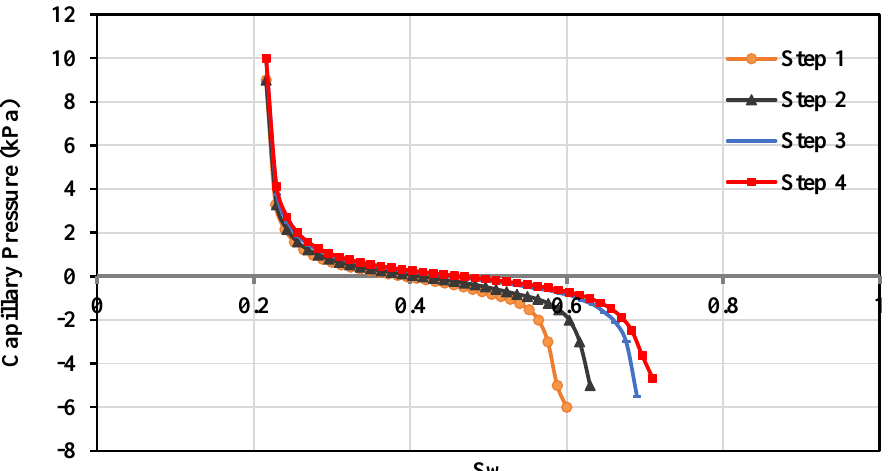
Figure 4. Relative permeability curves were used for LSWF simulation modeling with different salinities; step 1 is the formation water injection with a salinity of 3%, steps 2, 3, and 4 are with salinities of 1%, 0.5%, and 0.1%, respectively.